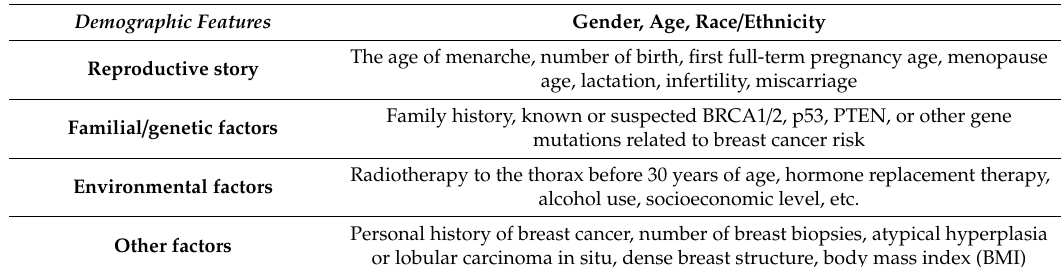
Table 1. Risk Factors in The Development of Breast